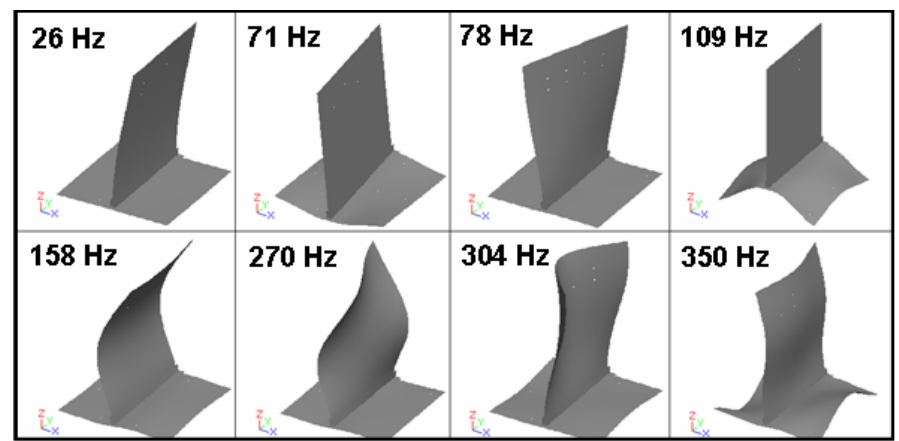
Fig. 9. First 8 mode shapes of the BU